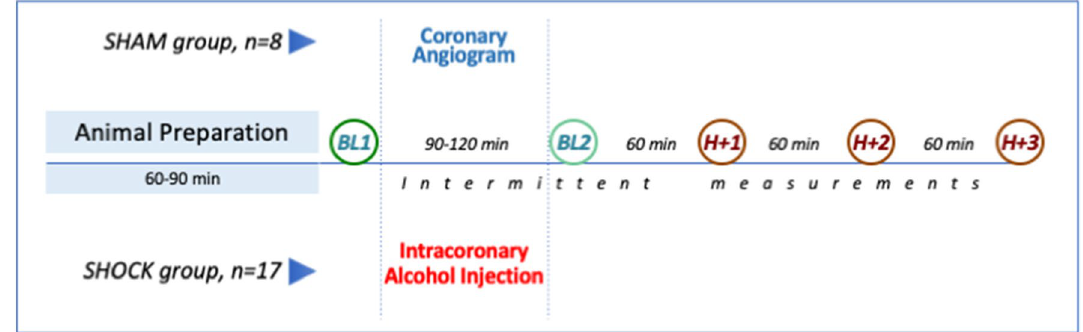
Figure 1. Study protocol. BL1 = baseline 1; BL2 = Baseline 2; H + 1 = 60 min after BL2; H + 2 = 120 min after BL2; H + 3 = 180 min after